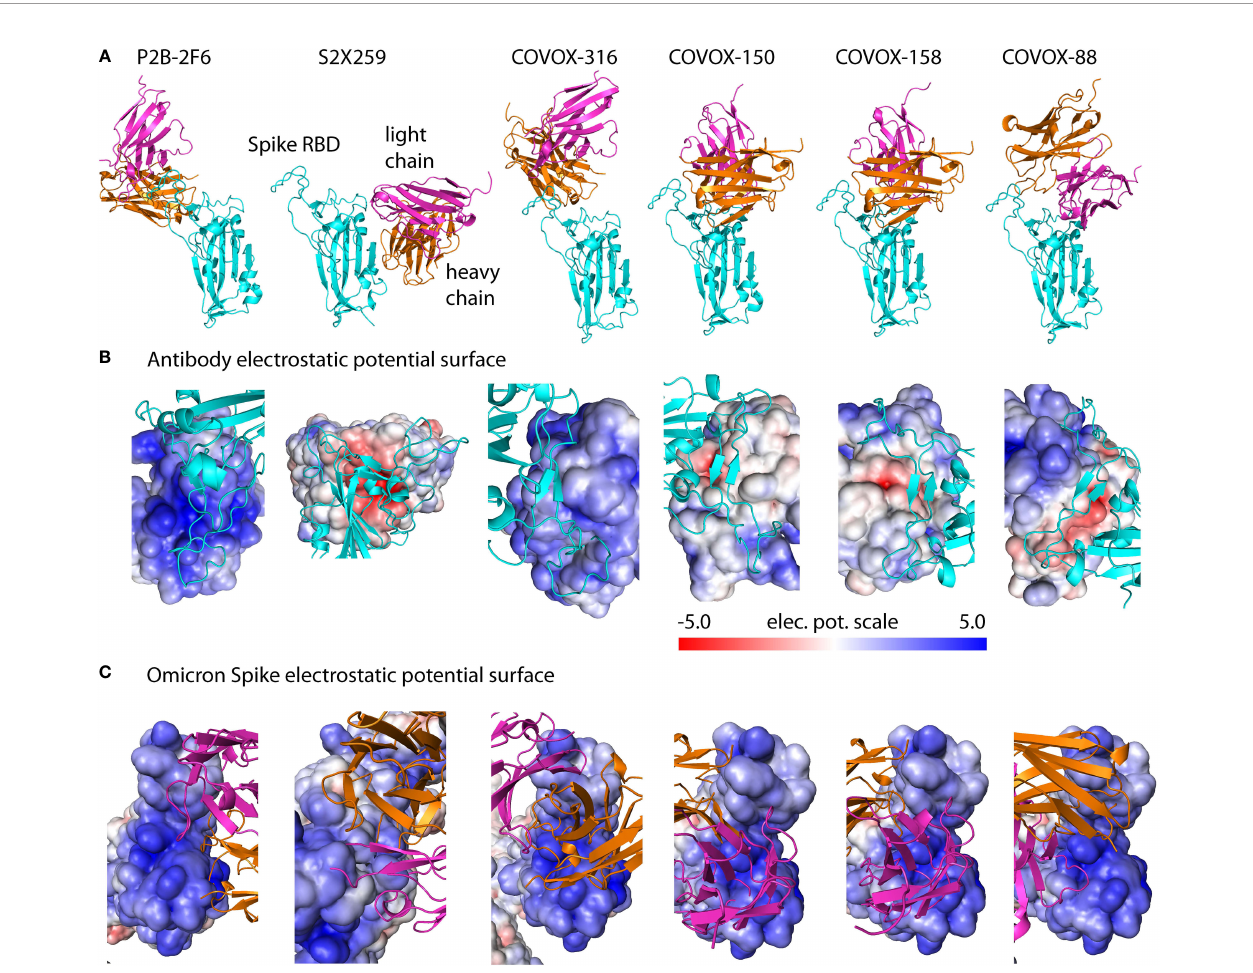
FIGURE 3 | Spike-antibody complexes and their electrostatic potential surfaces. (A) Solved structures of neutralizing antibodies targeting different sites on S RBD used for computational modeling. (B) Electrostatic surfaces of antibodies complexed with reference Spike. (C) Electrostatic surfaces of Omicron Spike modeled with different antibodies using templates in (A) . Spike-interacting interfaces on antibodies are predominantly positively charged which contribute to antibody resistance by Omicron. The color scale of the electrostatic potential surface is in units of kT/e at T =